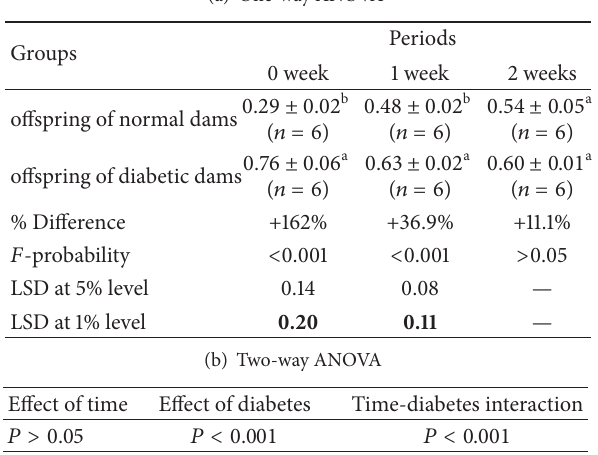
Table 4: HOMA-IS of offspring of normal and diabetic dams at different experimental